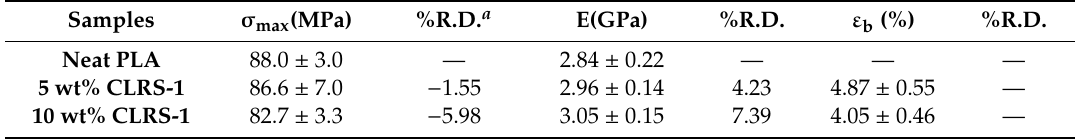
Table 3. Bending properties of PLA and PLA / CLRS-1 printed samples.